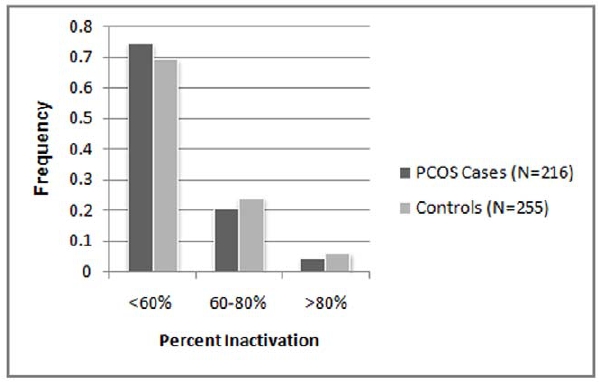
Figure 5. X-inactivation patterns in PCOS cases and controls.